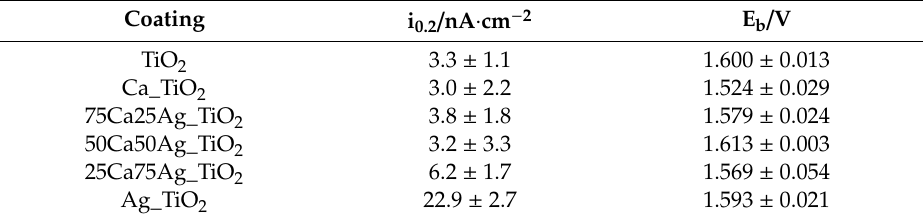
Figure 4. Potentiodynamic polarization curves of TiO 2 -based coatings in phosphate buffered saline (PBS) solution (scan rate 1 mV · s − 1 ). Table 3. Values of corrosion quantities determined from potentiodynamic characteristics.